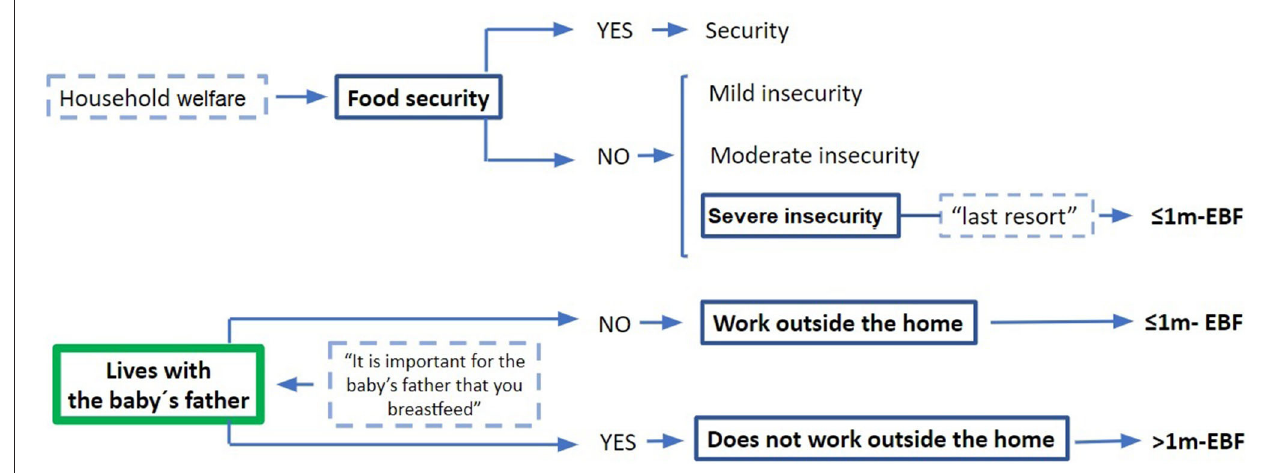
FIGURE 3 | Conceptual model of socioeconomic factors related to EBF.